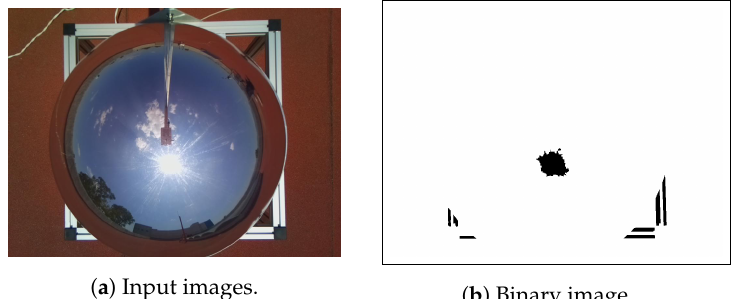
Figure 5. Binarization of the image. ( a ) shows the input color image. ( b ) shows the result of the binarization.